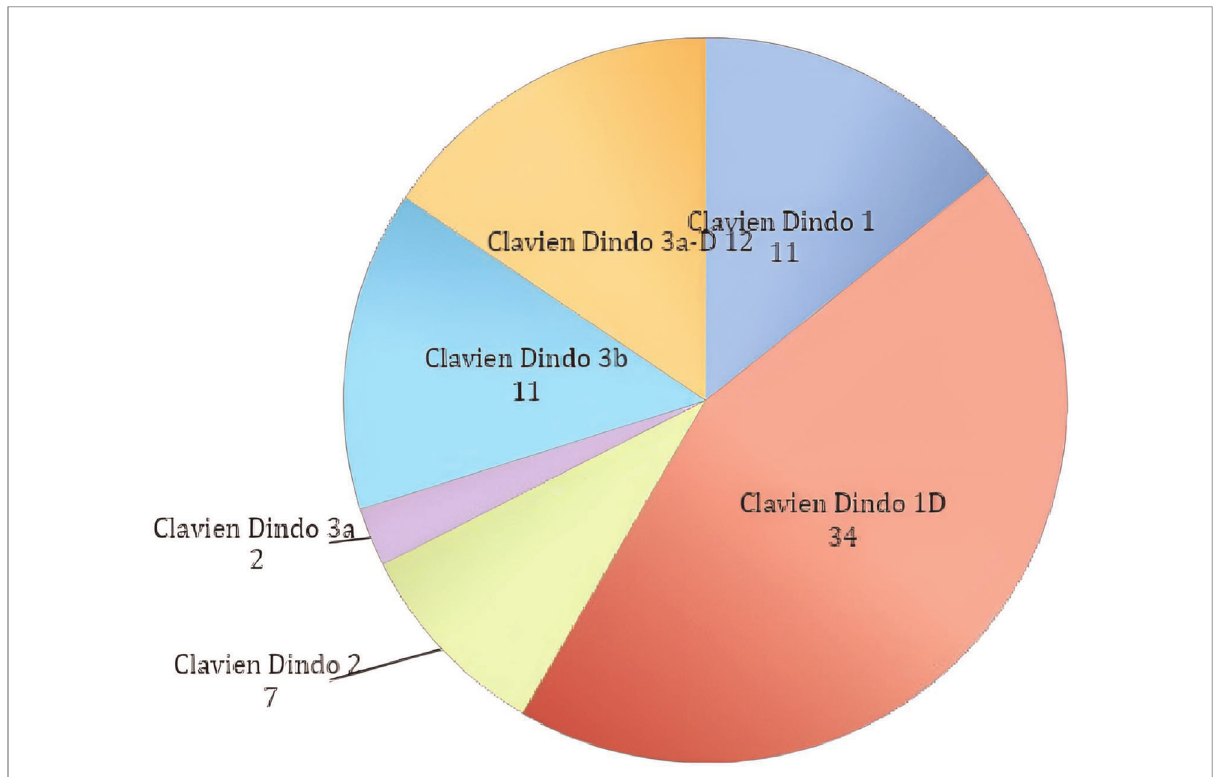
FIGURE 1 Total complications classi fi ed according to the clavien-dindo classi fi